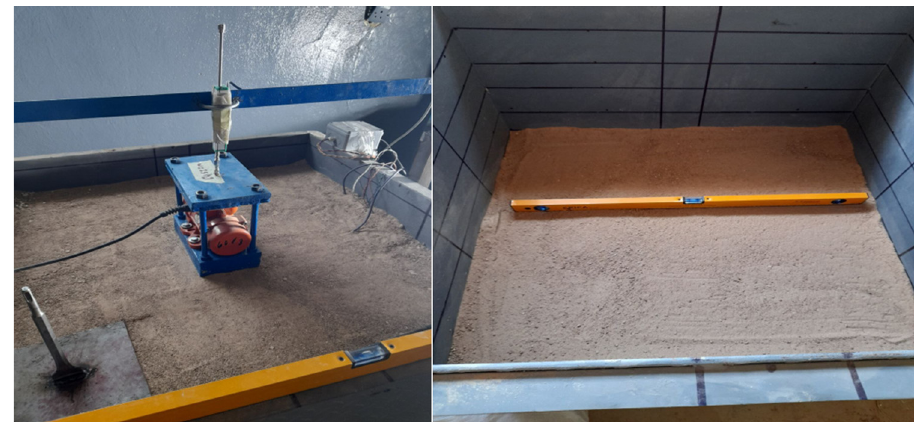
Figure 2: The model of steel test box.